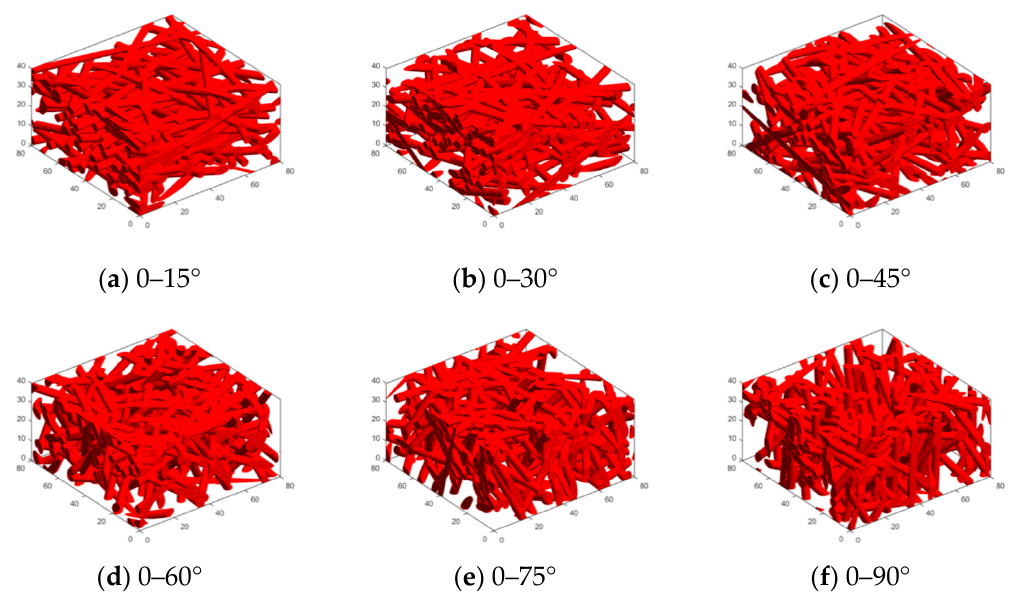
Figure 9. The random reconstruction results of carbon paper GDL ( a – f ) under different fiber pitch Figure9. TherandomreconstructionresultsofcarbonpaperGDL( a – f )underdi ff ranges.